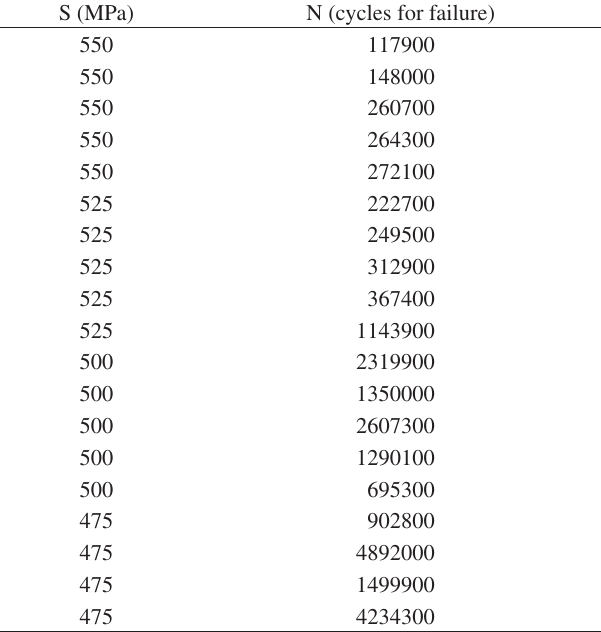
Table 2. S and N values for surface rolled notch testpieces of ductile cast